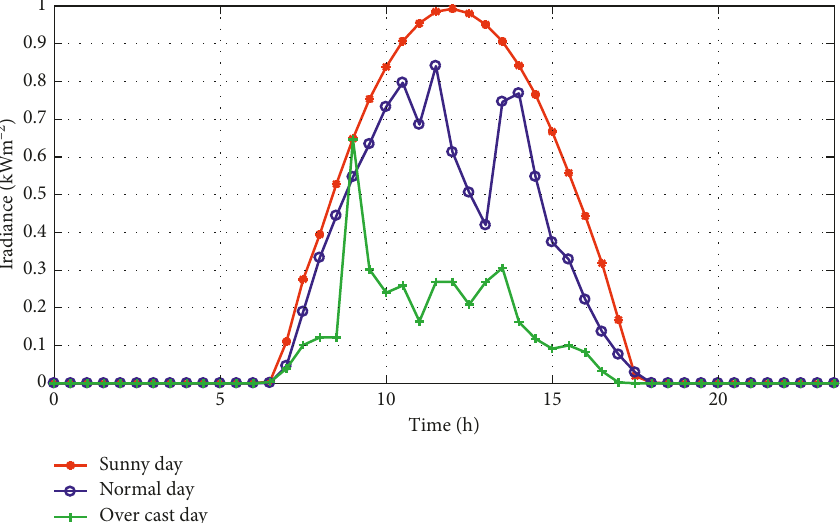
Figure 6: Obtained irradiance profiles.